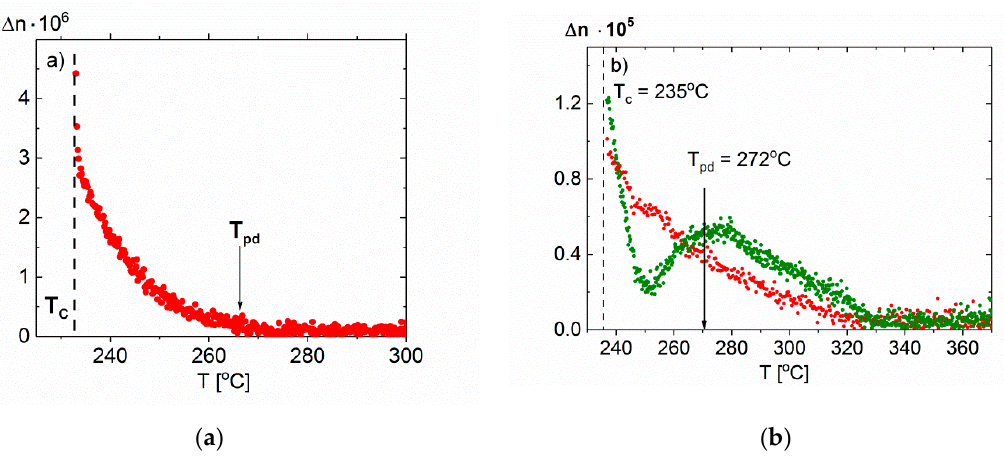
Figure 5 . Birefringence above T c for PbZrO 3 crystal doped with ( a ) 0.6mol% Nb 2 O 5 [32] and ( b ) 1.0mol% Nb 2 O 5 [33]. T pd is the temperature at which the piezo-deformation signal disappears.